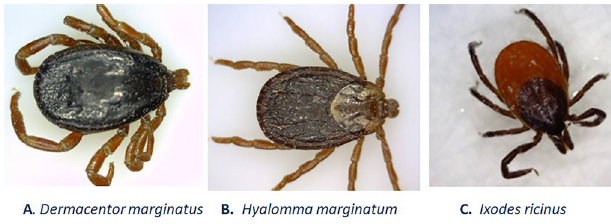
Figure 2 . Most Commonly Seen Tick Species That Transmit Pathogens To Humans. (A) Dermacentor marginatus , (B) Hyalomma marginatum , (C) Ixodes ricinus